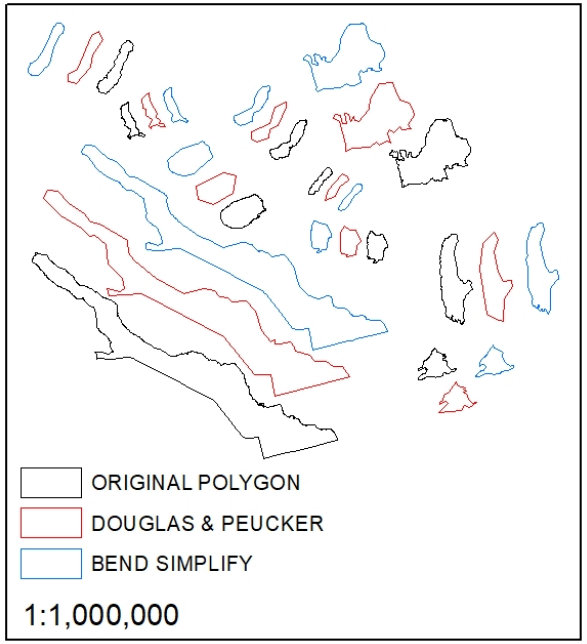
Figure 8. Polygon features generalized with the Douglas–Peucker simplification algorithm (red) and bend simplification algorithm (blue). Original polygons are depicted in black (scale 1: